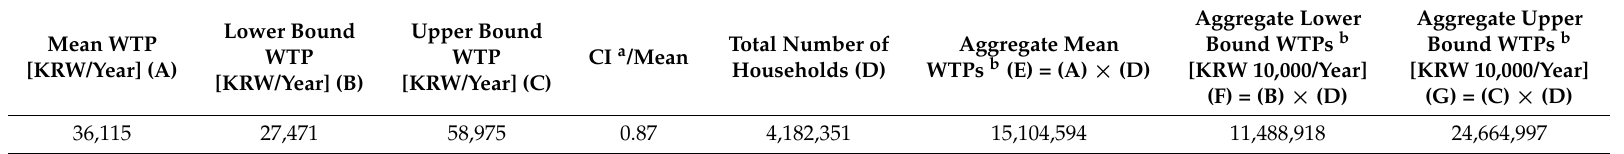
Table 2. An annual mean Willingness to Pays (WTPs) and aggregate Willingness to Pay (WTP)